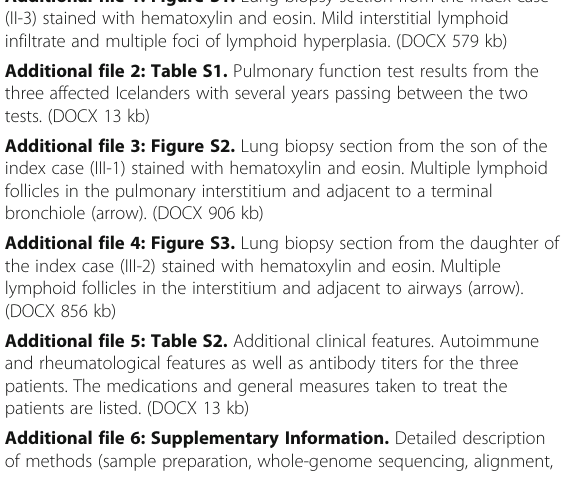
Additional file 1: Figure S1. Lung biopsy section from the index case (II-3) stained with hematoxylin and eosin. Mild interstitial lymphoid infiltrate and multiple foci of lymphoid hyperplasia. (DOCX 579 kb) Additional file 2: Table S1. Pulmonary function test results from the three affected Icelanders with several years passing between the two tests. (DOCX 13 kb) Additional file 3: Figure S2. Lung biopsy section from the son of the index case (III-1) stained with hematoxylin and eosin. Multiple lymphoid follicles in the pulmonary interstitium and adjacent to a terminal bronchiole (arrow). (DOCX 906 kb) Additional file 4: Figure S3. Lung biopsy section from the daughter of the index case (III-2) stained with hematoxylin and eosin. Multiple lymphoid follicles in the interstitium and adjacent to airways (arrow). (DOCX 856 kb) Additional file 5: Table S2. Additional clinical features. Autoimmune and rheumatological features as well as antibody titers for the three